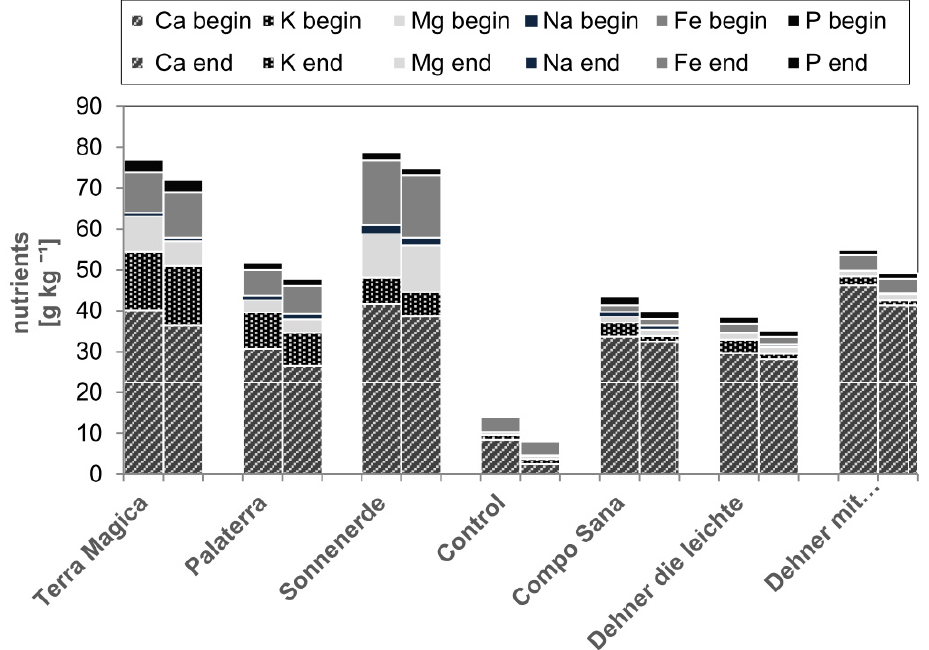
Figure 5. Plant-available nutrient content of the different biochar-based and peat-based growing media at the beginning of the three growing seasons (barley, wheat, and maize, left columns) and after the plant growth experiment (right columns).